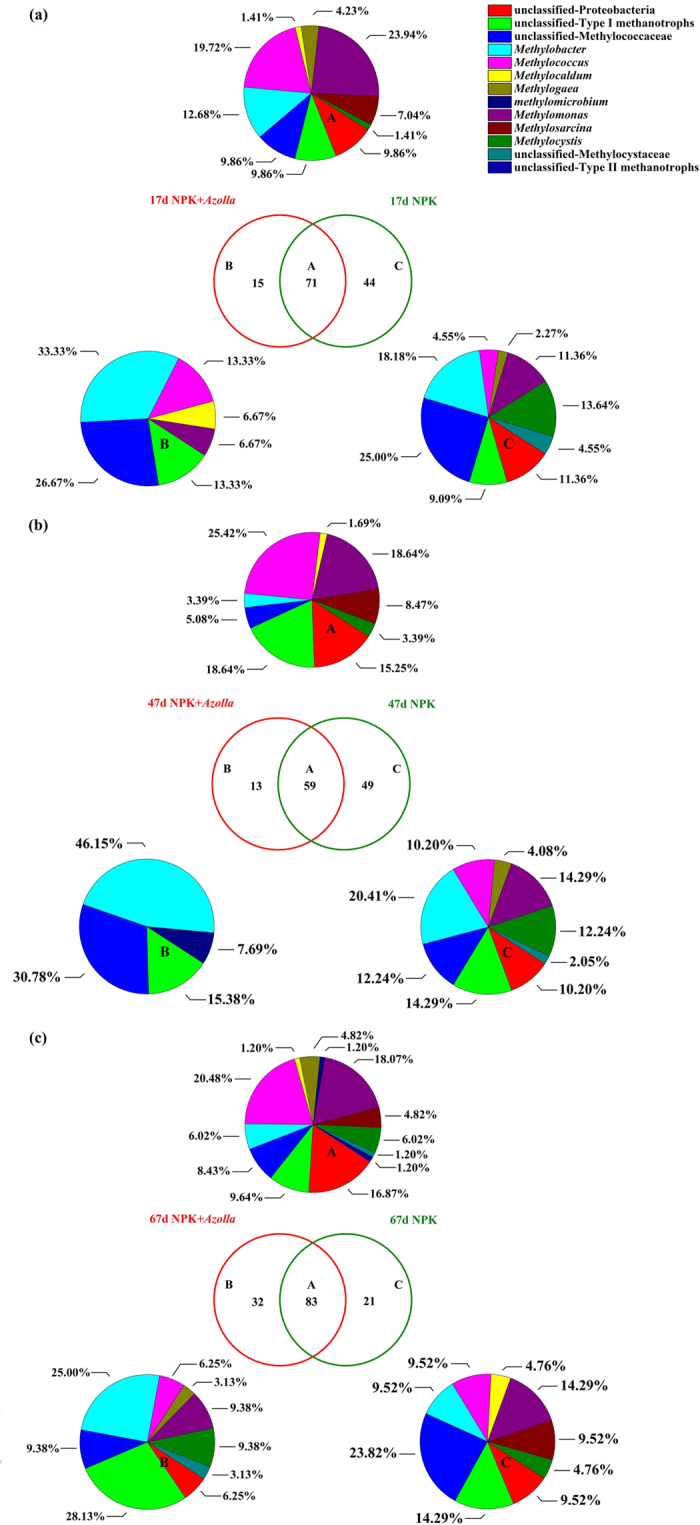
Venn diagrams and pie charts showing the distribution of methanotrophic pmoA OTUs in the two treatments across three sampling times, day 17 (a), day 47 (b) and day 67 (c) after rice transplantation. The numbers within the Venn diagrams indicate the number of OTUs shared between two treatments (A) or unique to the given treatment (B,C) (unique OTUs were identified as unique that were found in all three replicates of one treatment but not in any of the triplicates of the other treatment). The pie charts denote the taxonomic identity and distribution of shared (A) or unique (B and C) OTUs. NPK, rice cropping without dual cropping of Azolla under recommended fertilization; NPK + Azolla, rice cropping with dual cropping of Azolla under recommended fertilization.